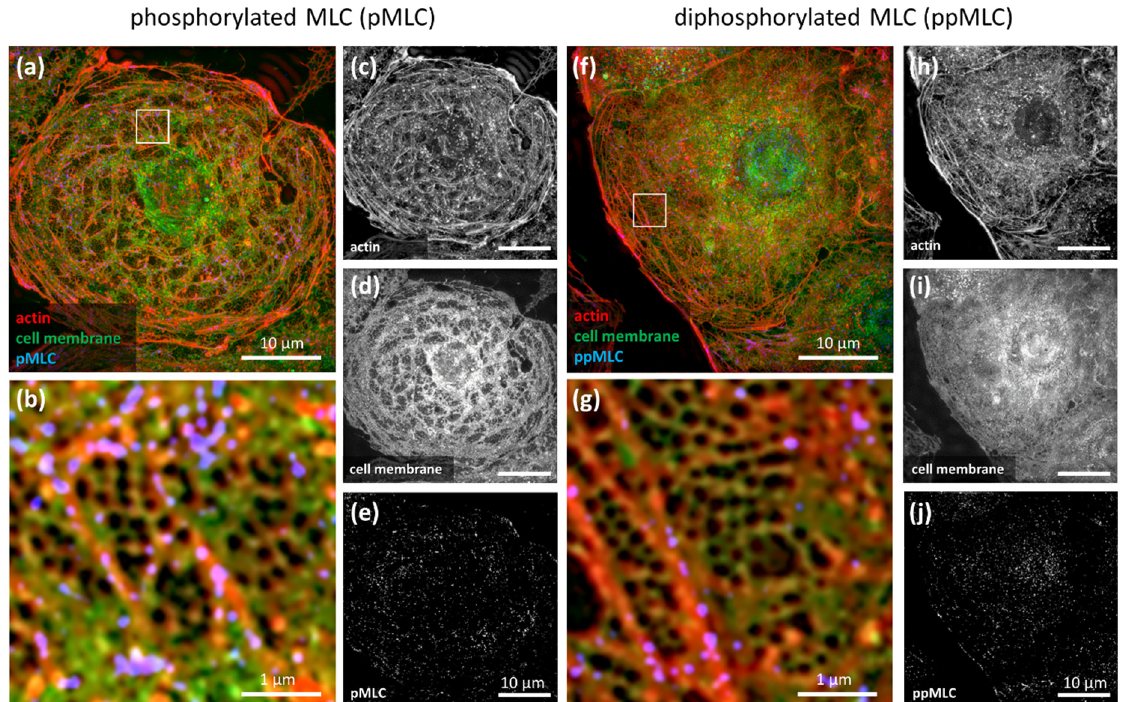
Figure 1. Immunofluorescence images of untreated LSEC collected using SIM. pMLC ( a – e ) and ppMLC ( f – j ). Individual black and white channels show actin (phalloidin-Atto647N, ( c , h ), cell membrane (CellMask Orange), ( d , i ), and pMCL/ppMLC staining ( e , j )). Coloured images show merged channels. The selected areas of sieve plates (white boxes) were digitally magnified ( b , g ). The antibody is located on actin fibres at the edges of a sieve plate, and not within a sieve plate. ppMLC was also concentrated in the nuclear area. Image size: 40.96 µm × 40.96 µm, inset size: 4.1 µm × 4.1 µm. A gamma of 0.4 was used for the actin and cell membrane for better visualization of the data.